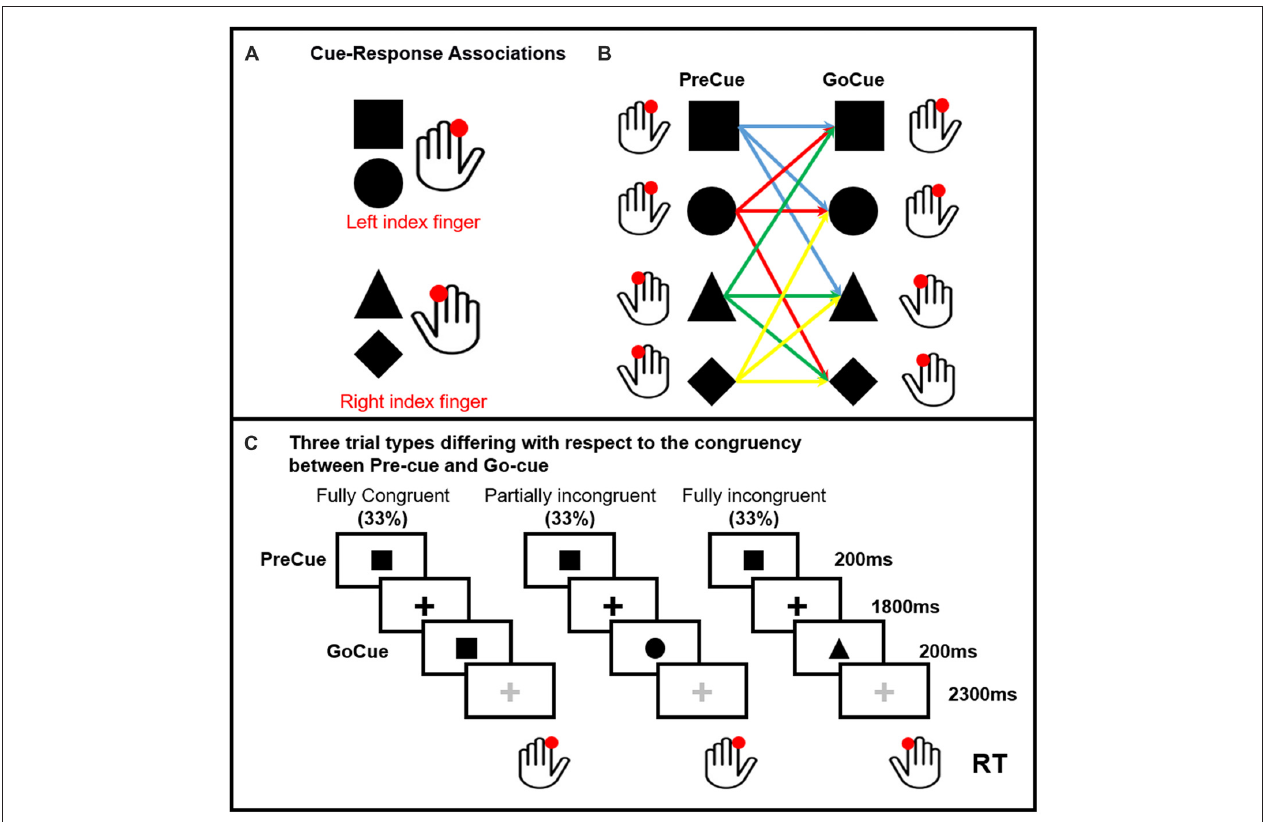
FIGURE 1 | Pre-cued alternate-choice task. Participants were asked to respond as fast as possible to a GoCue with a correct button press. Arbitrary shape-response associations were learned by the participants prior to the experiment. Panel (A) Cue-response associations: the square and circle required a button press with the left index finger. The triangle and diamond required a button press with the right index finger. The cue-response associations were varied across individuals, but kept constant within subjects. Panel (B) shows all the possible PreCue GoCue combinations. Panel (C) Trial structure: a PreCue appeared for 200 ms on the screen and predicted the movement with a probability of 66%. A GoCue appeared 1,800 ms after the PreCue had disappeared and was presented for 200 ms. In one third of the trials, PreCue and GoCue were identical (i.e., fully congruent trials). Hence, the PreCue predicted the GoCue and the action. In 33% of trials the shape of the GoCue differed from the shape of the PrCue, but the GoCue instructed the same movement as the PreCue (i.e., partially incongruent trials). Hence, the altered go-cue required only a re-evaluation of the cue but no change in selection of the pre-cued response. In the last third of the trials, the PreCue and GoCue differed in shape and coded different actions (i.e., fully incongruent trials). In this trial condition, not only the go-cue needed to be re-evaluated, but also the pre-cued response needed to be suppressed and the alternate response had to be selected (i.e., motor